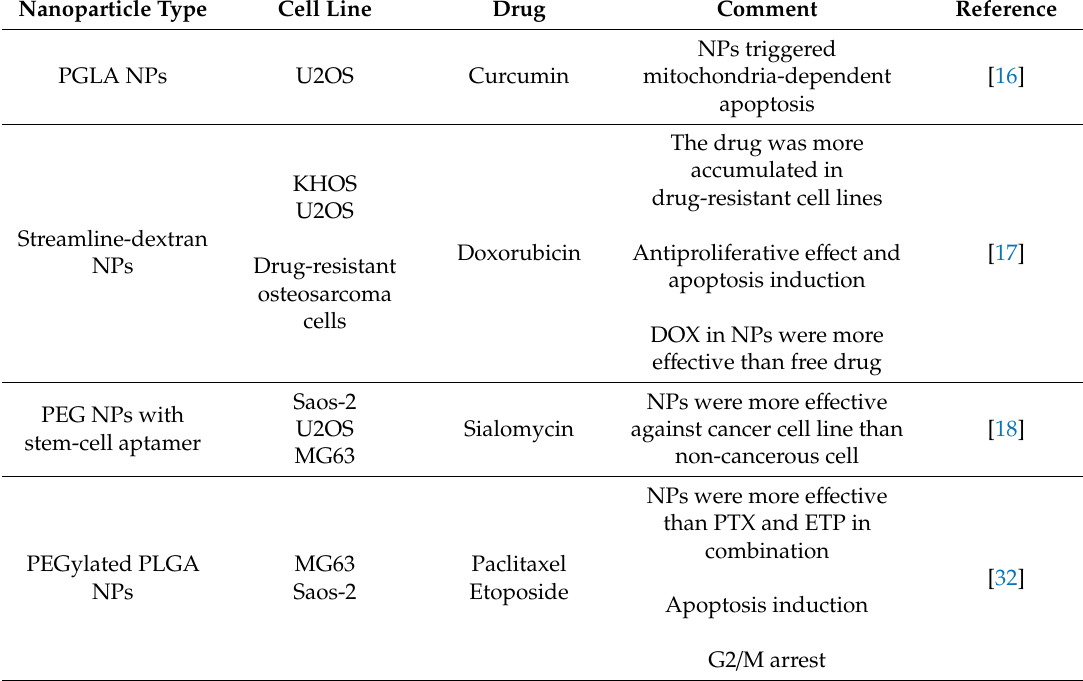
Table 3. Summary of NPs properties as drug delivery